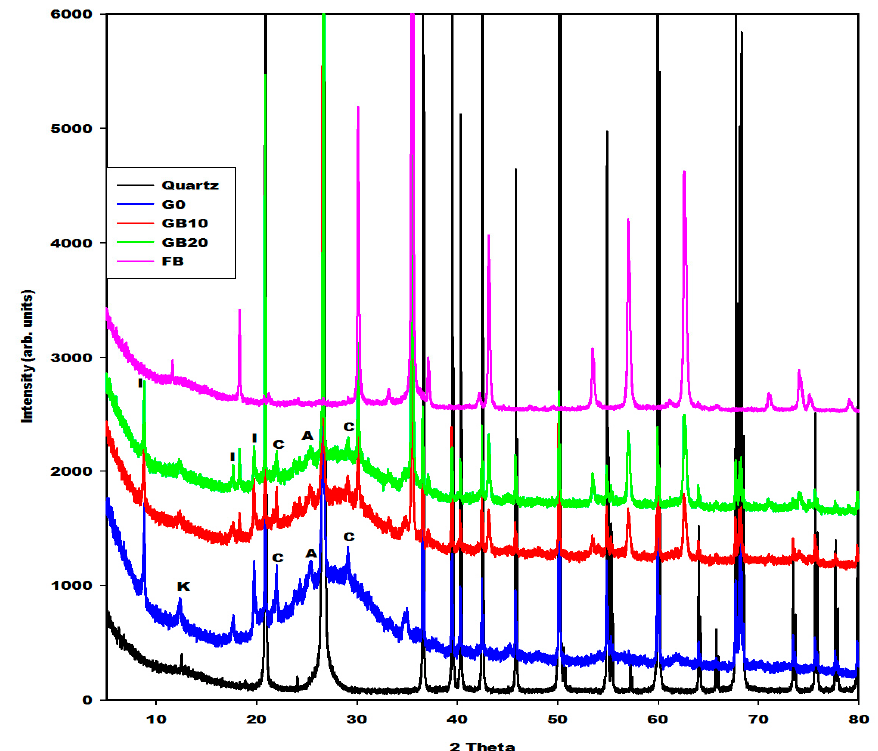
Figure 6. X-ray patterns of geopolymer materials (G0, GB10, GB20, quartz and FB: Magnetite). I, K, A and C denotes the peaks of illite, kaolinite, anatase and cristobalite, respectively.